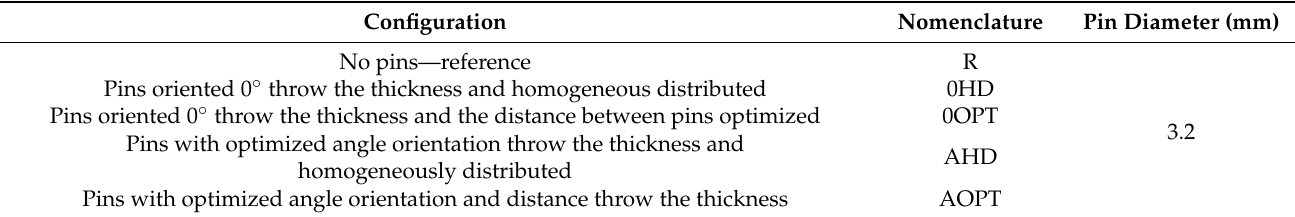
Table 1. Z-pin-reinforced sandwich panels’ nomenclature and configuration.